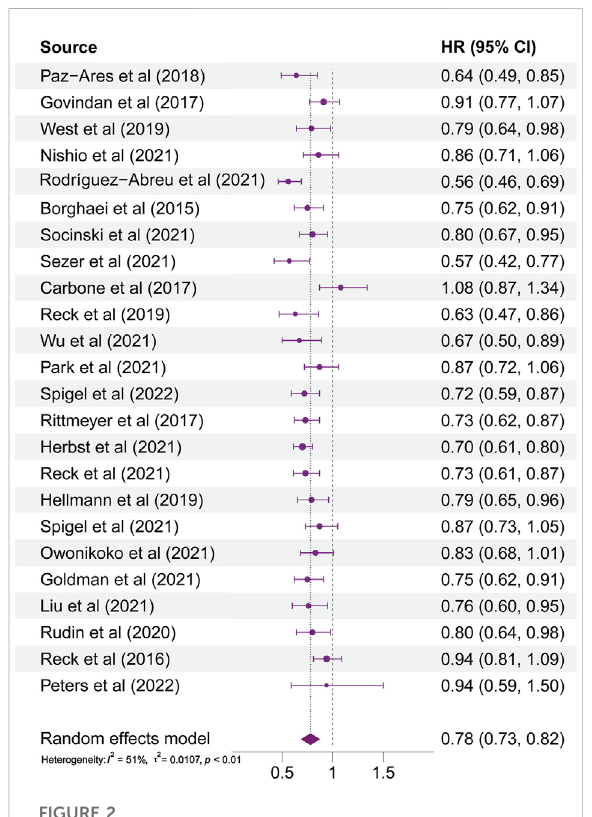
FIGURE 2 Forest plot of all patients ’ hazard ratios for overall survival.